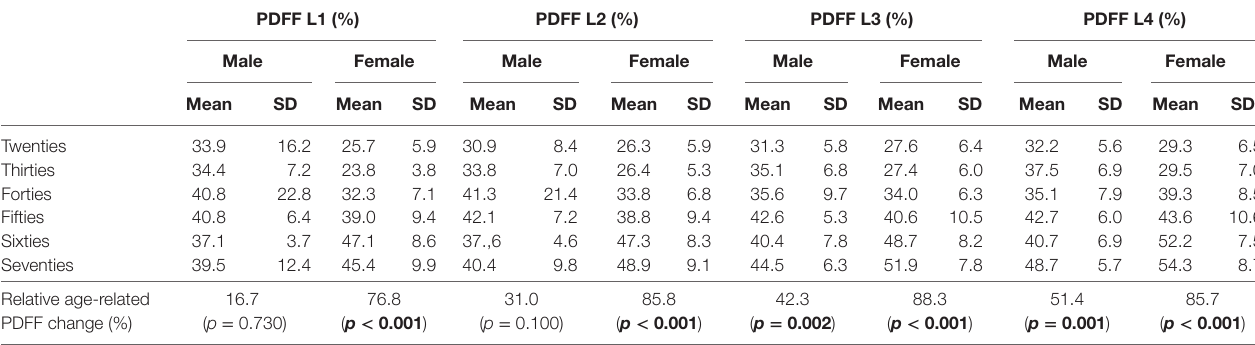
TaBle 3 | Anatomical variation of proton density fat fraction (PDFF) values for each age group and sex. PDFF l1